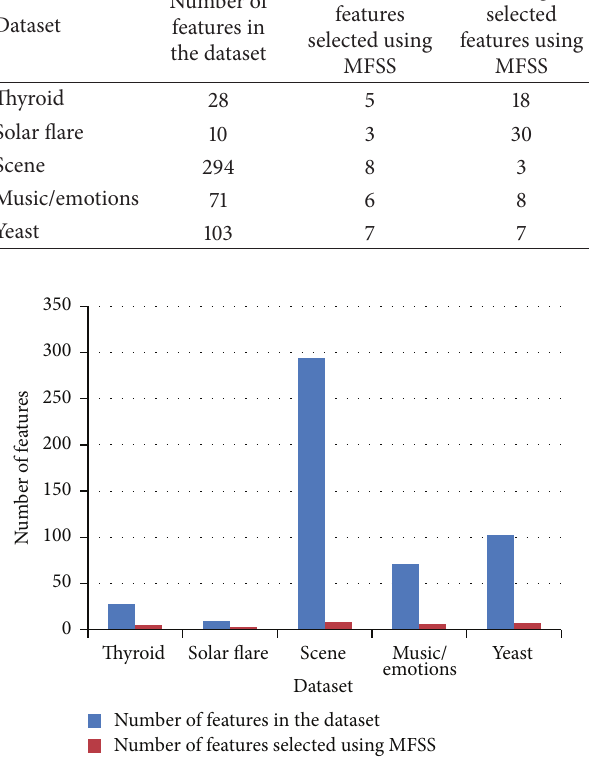
Figure 11: Features selected using proposed